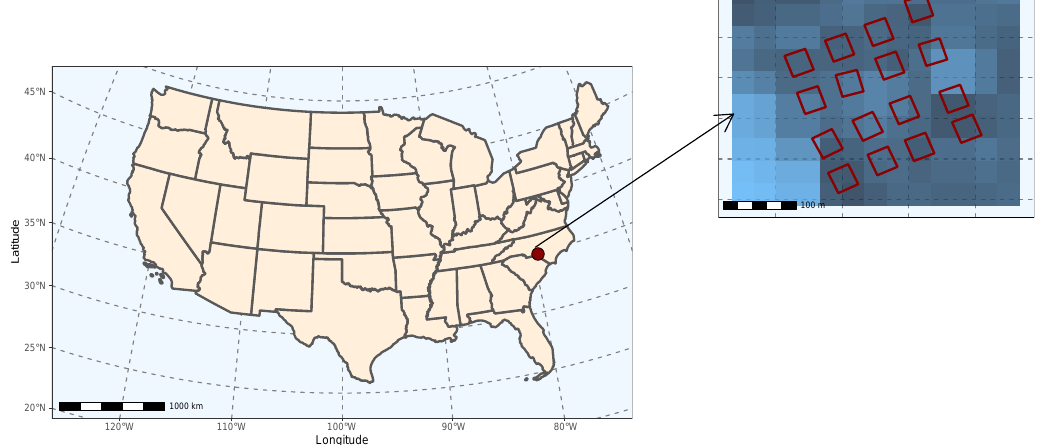
Figure 1. Location and study plot layout of the Southeast Tree Research and Education Site (SETRES) in Scotland County, North Carolina. The inset map shows the Landsat 5 Thematic Mapper pixel size and location in relation to the SETRES study